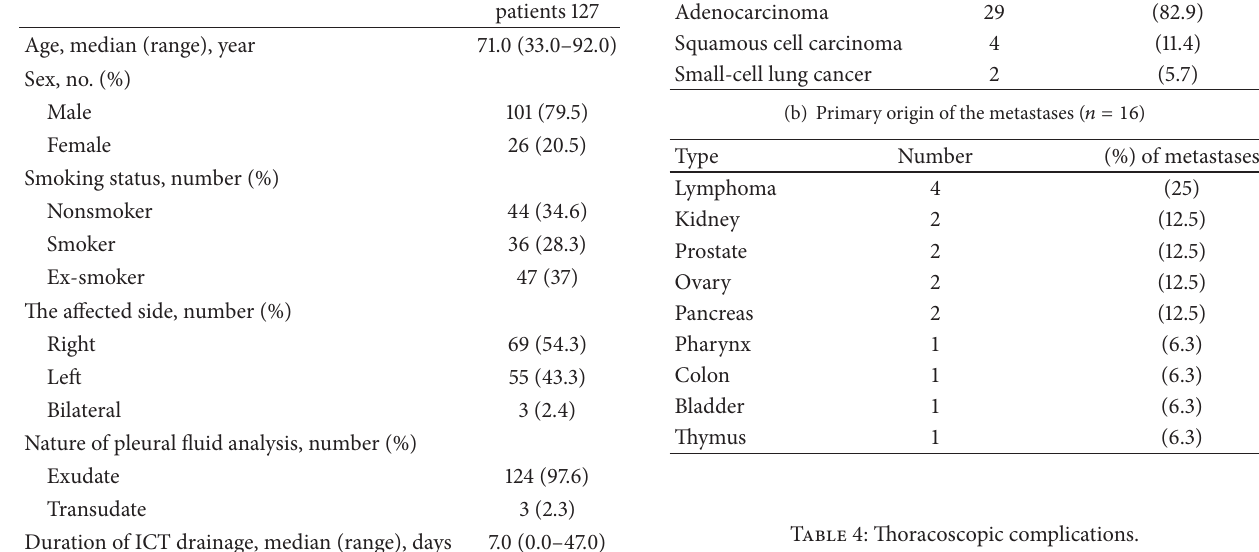
Table 4: Thoracoscopic